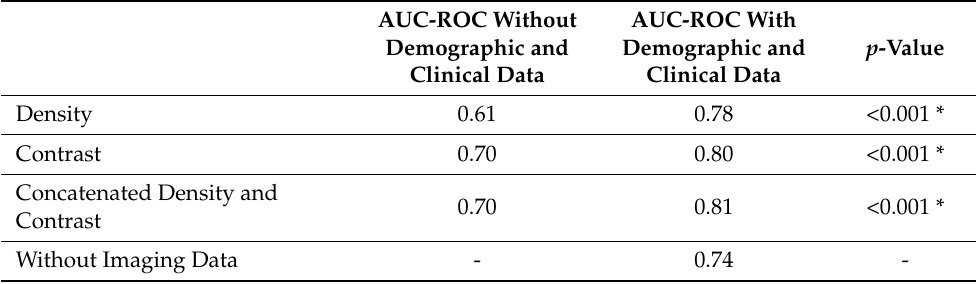
Table 4. Comparison of model accuracies with and without inclusion of demographic and clinical data (age, race, past medical history of breast cancer, menopausal status, and breast density). AUC- ROC: area under the curve for the receiver operating characteristic curve. * statistically significant ( p ≤